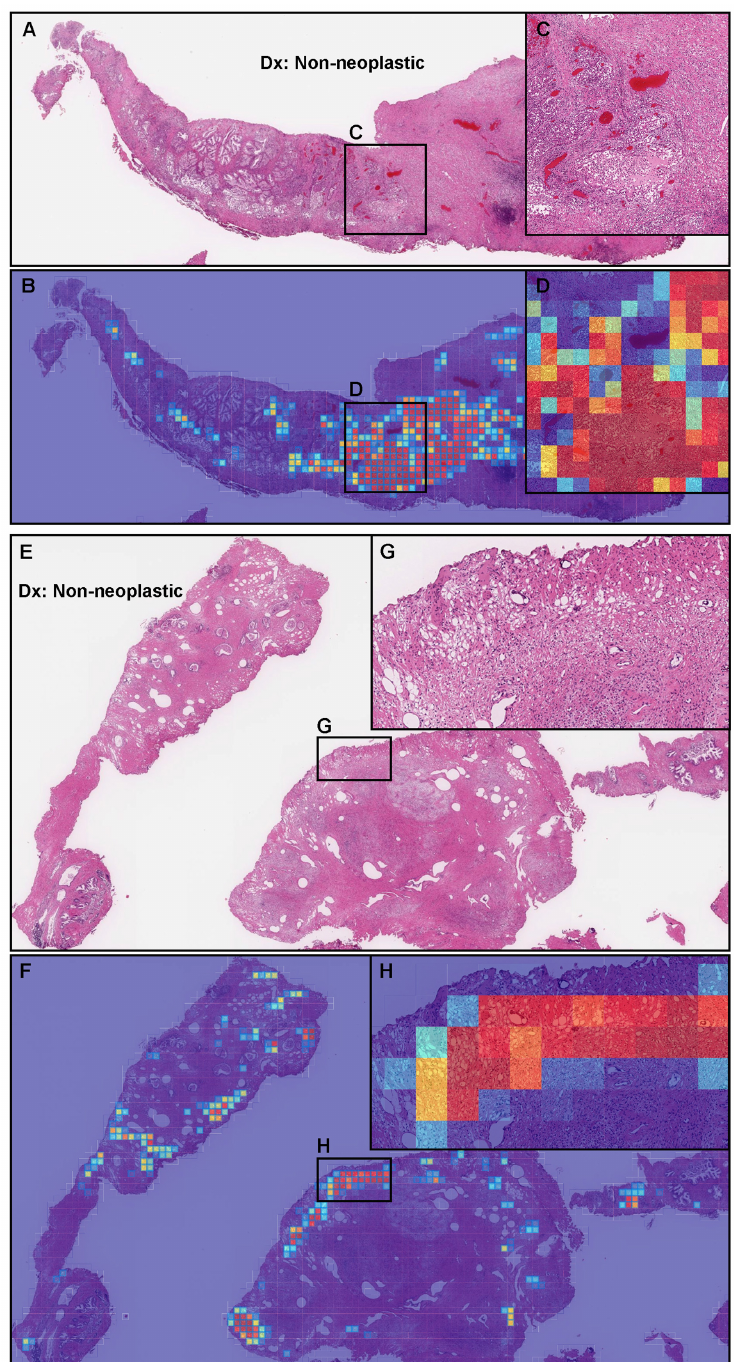
Figure 7. Representative examples of prostate adenocarcinoma false positive prediction outputs on cases from the transurethral resection of the prostate (TUR-P) test sets. Histopathologically, ( A , E ) are benign (non-neoplastic) lesions. The heat map images ( B , F ) exhibit false positive predictions of adenocarcinoma ( D , H ) using transfer learning from the colon poorly differentiated adenocarcinoma model (TL-colon poorly ADC-2 (20 × , 512)). Inflammation with infiltration of inflammatory cells including foam cells ( C ) would be the primary cause of the false positives due to a morphology analogous to adenocarcinoma cells’ infiltration ( D ). The cauterized area of the marginal zone of the specimen ( G ) would be the primary cause of the false positives ( H ). The heat map uses the jet color map where blue indicates low probability and red indicates high